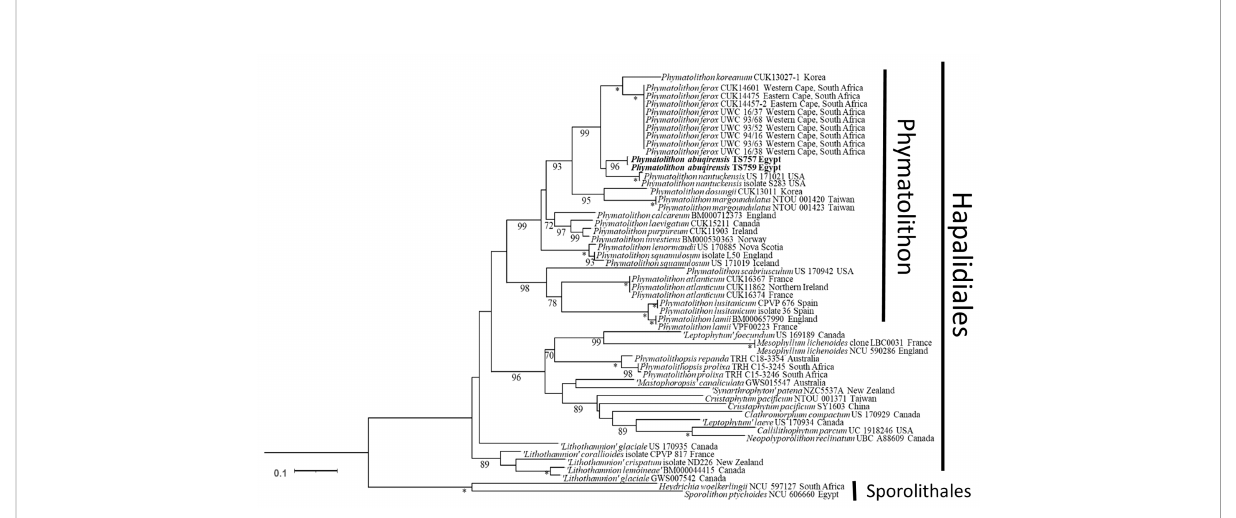
FIGURE 4 ML analyses of concatenated psb A and rbc L sequences (2,453 bp). Numbers at branches indicate bootstrap values out of 1,000 replicates.* denotes full support.